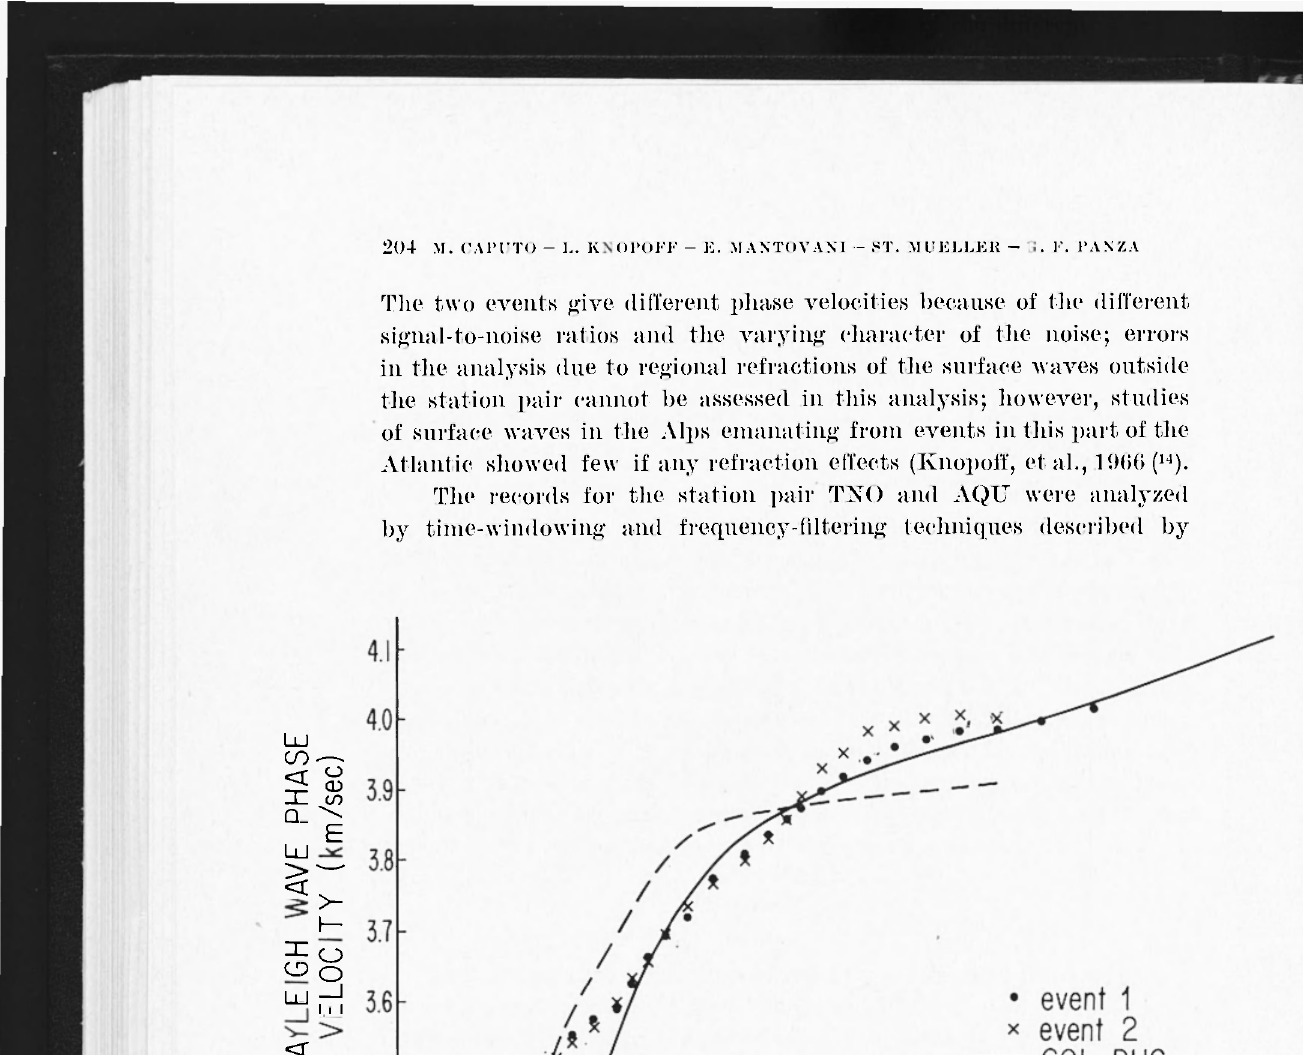
Fig. 2 - .Measured Ravleigh wave phase velocities for events 1 and 2 for path TNO-AQU. Comparison can be made with measured phase velocities for Alpine path BES-CIIU and U.S. path